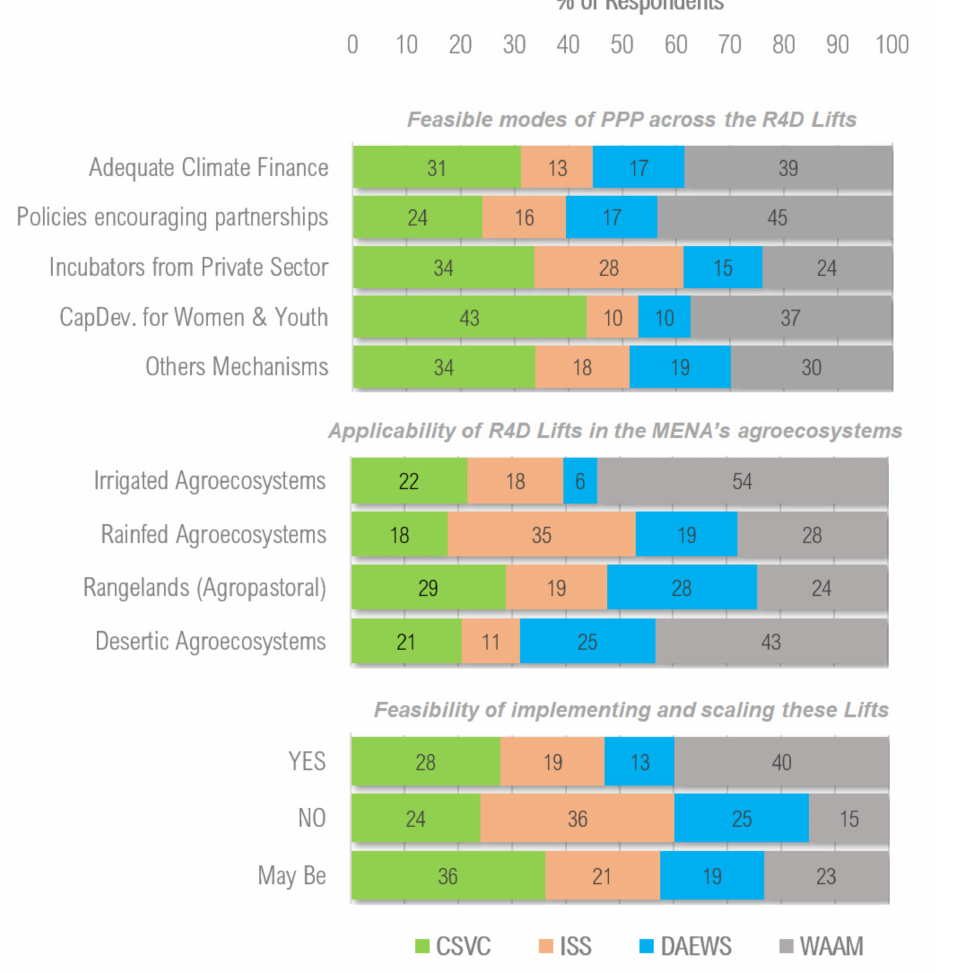
Figure 7. The bar chart represents survey results based on ~400 respondents’ viewpoints to the set of hypothesis